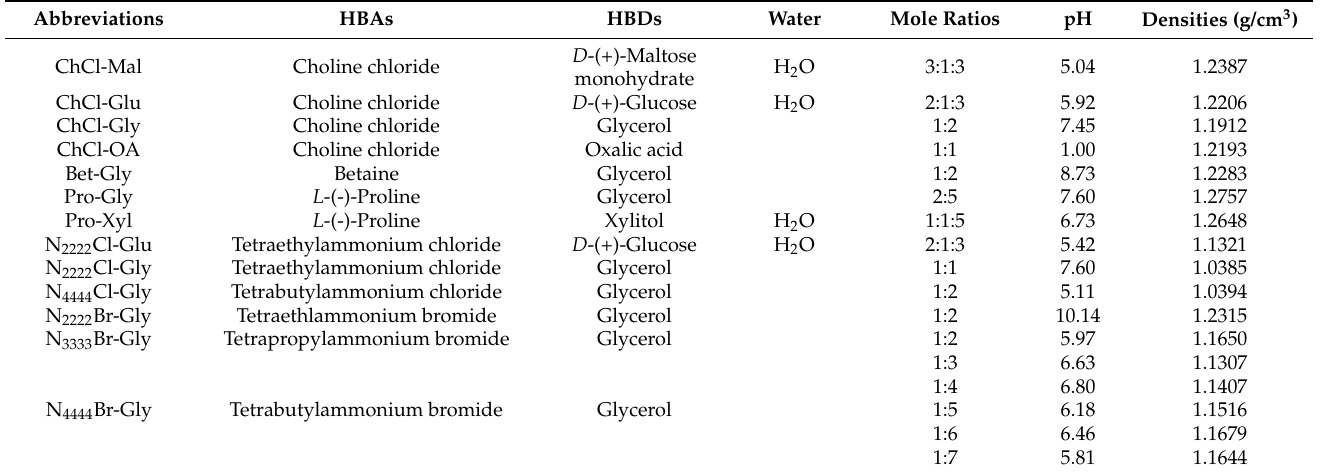
Table 1. The abbreviations, molar ratios, pH, and densities of DESs